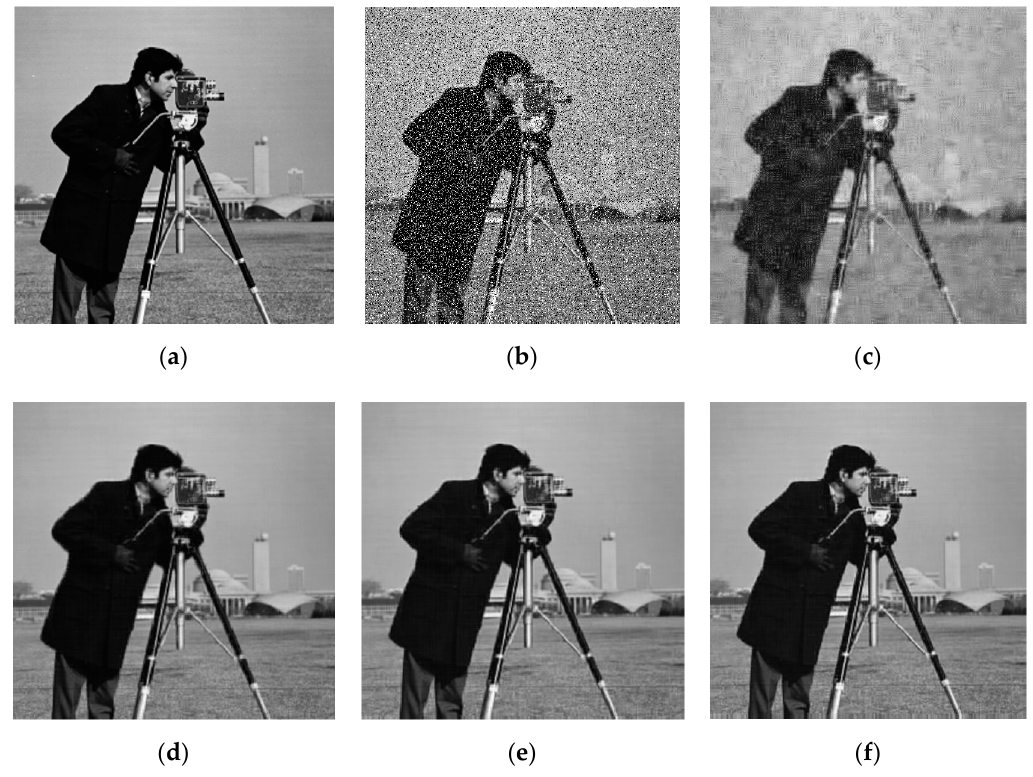
Figure 7. Image denoising result with salt and pepper noise: ( a ) original image; ( b ) noised image; ( c ) ISTA; ( d ) negentropy + (cid:96) 1 -norm; ( e ) negentropy + weighted (cid:96) 1 -norm; ( f ) negentropy + (cid:96) 0.5 -norm. Table 3. Denoising results (peak signal-to-noise ratio (PSNR) in dB) of the di ff erent methods in two noise conditions.